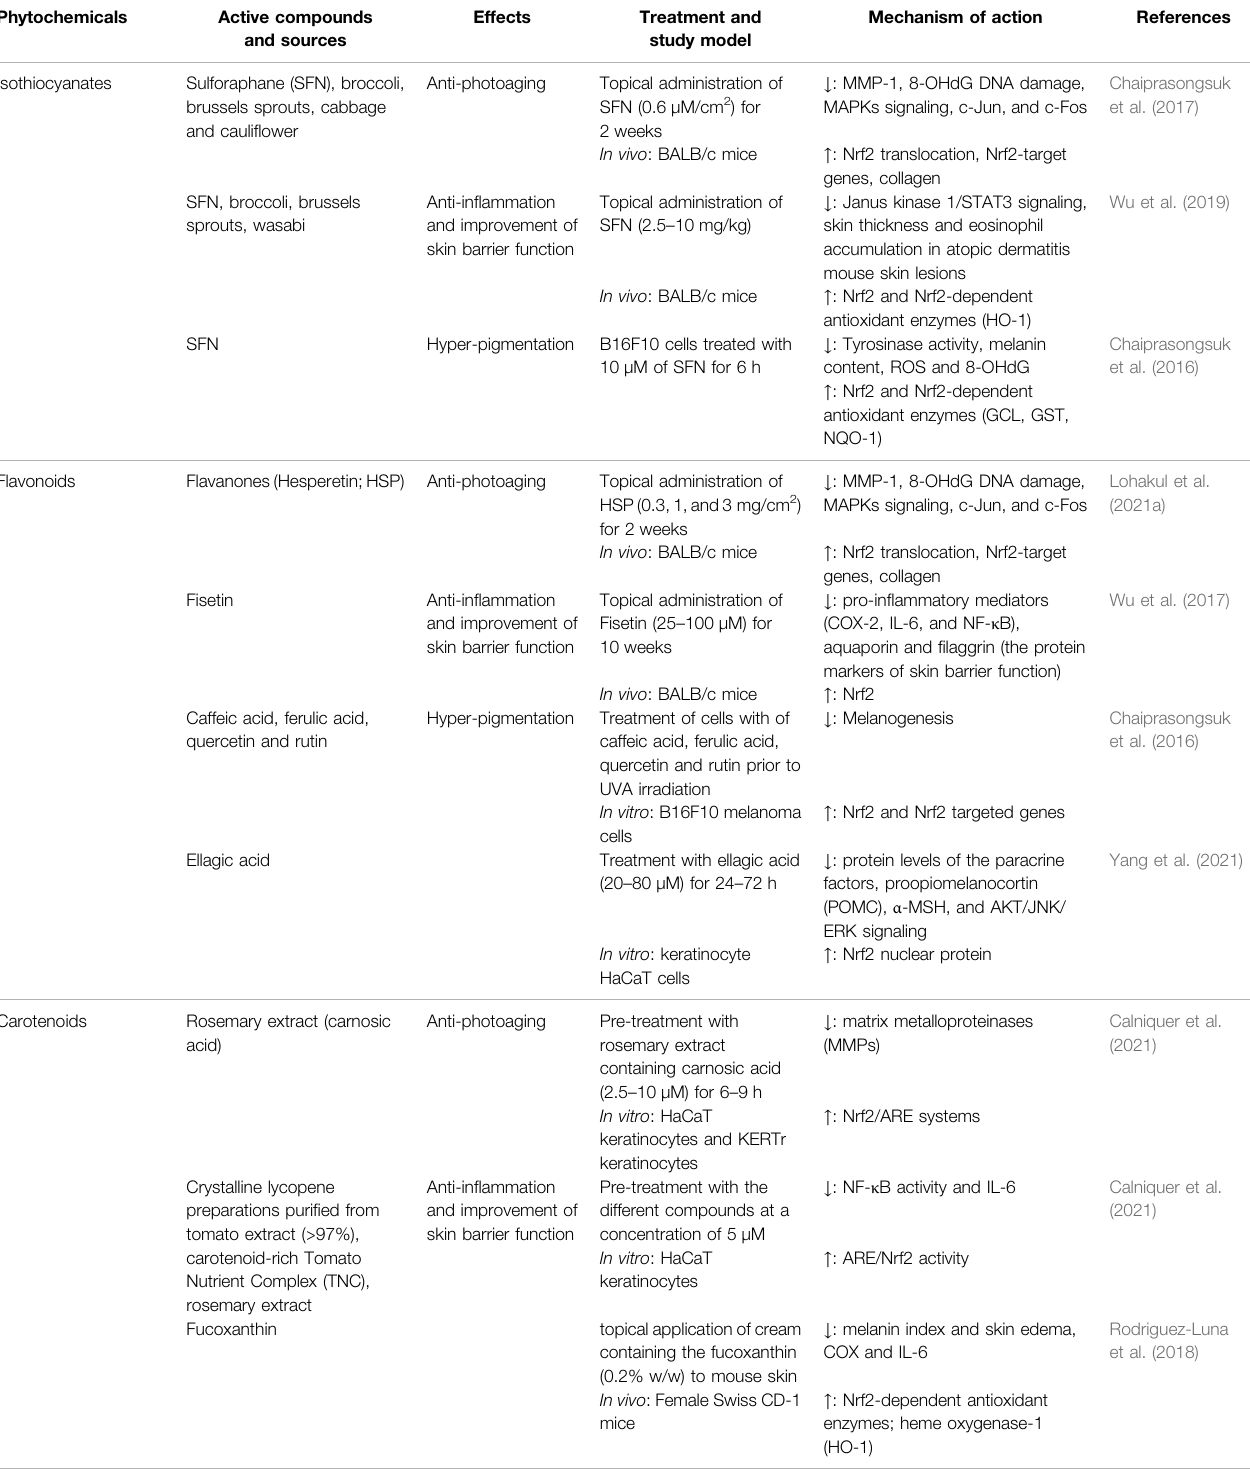
TABLE 1 | The protective roles of botanicals and phytochemicals against photoaging, in fl ammation, skin barrier dysfunction and hyperpigmentation via Nrf2 regulation.